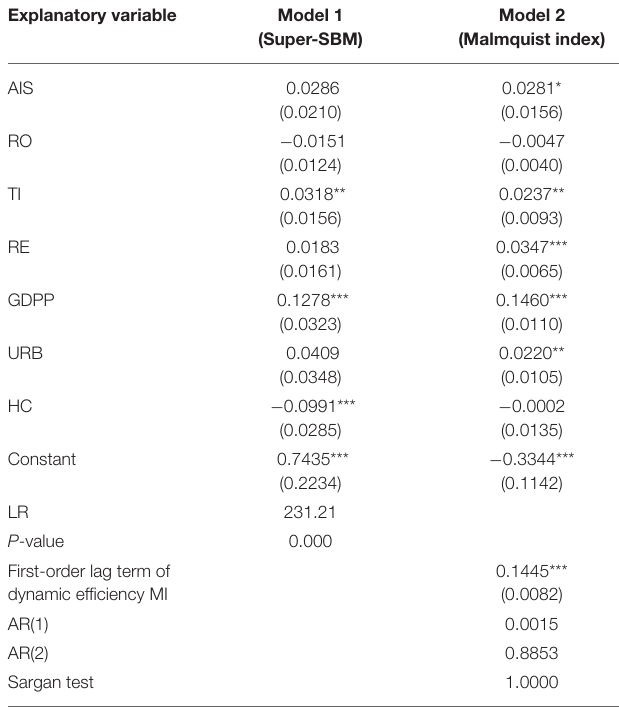
TABLE 4 | Regression results of influencing factors of static efficiency and dynamic efficiency of green transformation in western resource-based